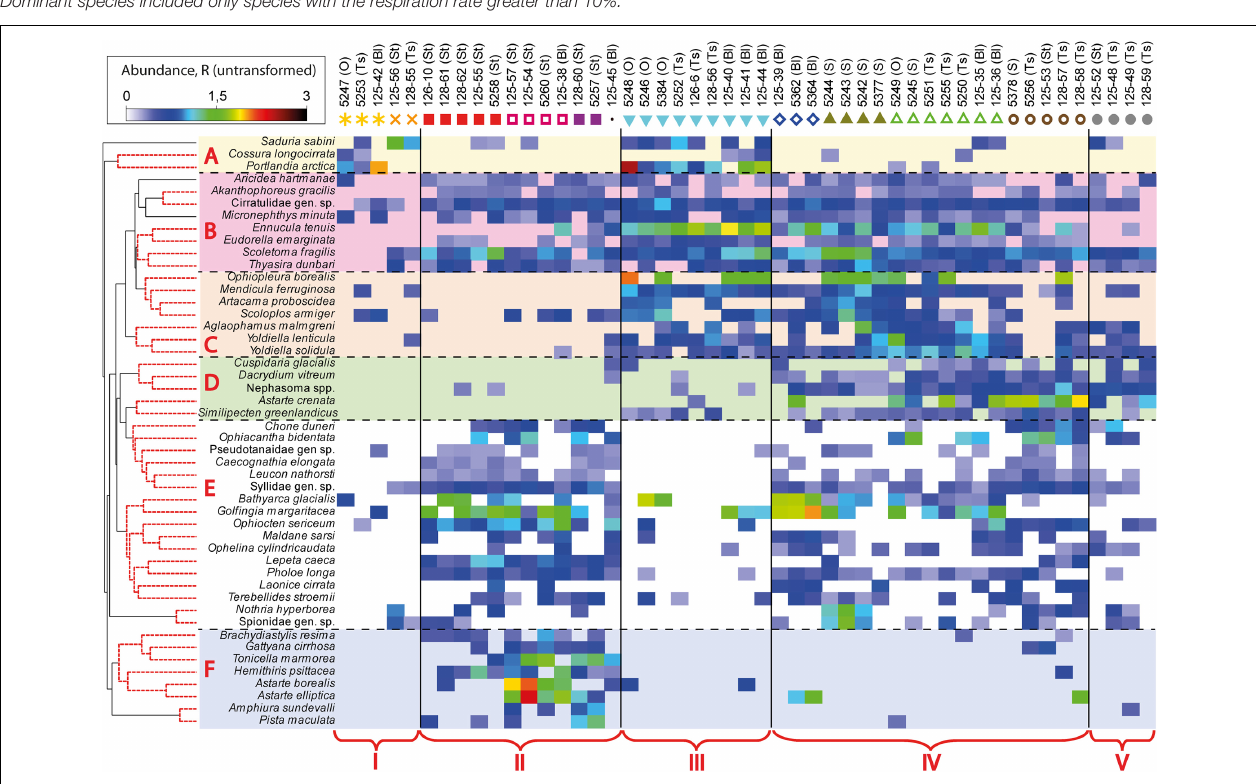
FIGURE 4 | Shade plot of untransformed species respiration rates data. The key species that provided a high proportion of within-group similarity (by SIMPER) in station groups (according to the 11 clusters identified) were selected for analysis. Species grouped using UPGMA clustering based on index of association. The colors and symbols indicating clusters are the same as in Figure 3 . Five fjord zones differing in the structure of benthic communities are marked with the following symbols: I, II, III, IV, and V.